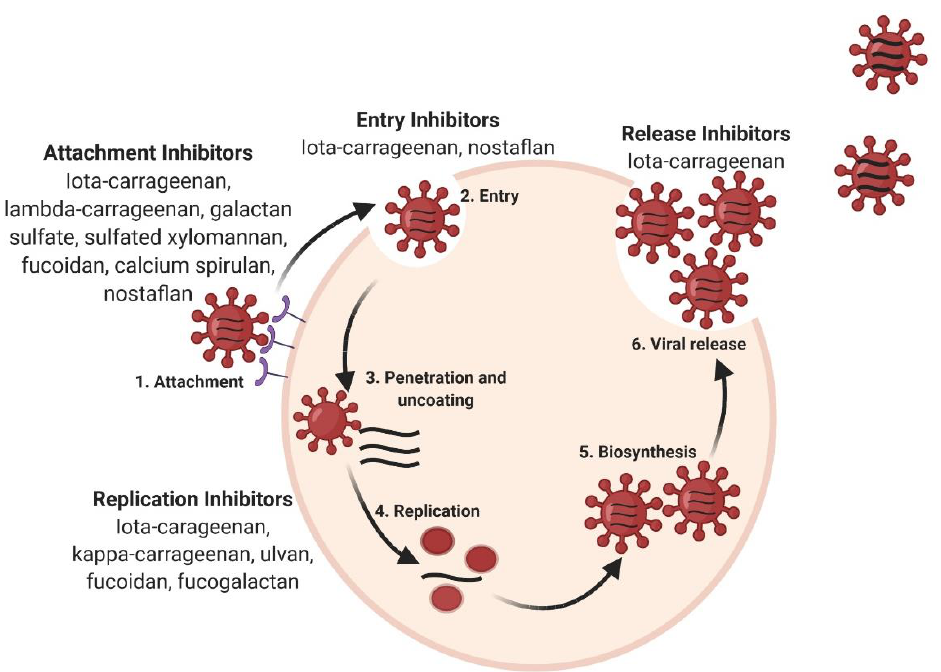
Figure 2. Mechanism of action of seaweed sulfated polysaccharides at various stages of the viral